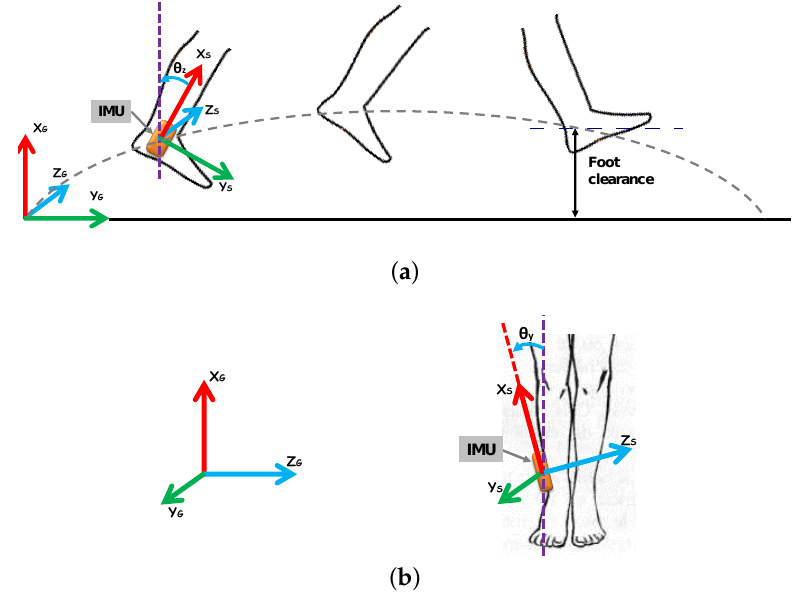
Figure 1. IMU placement and frame transformation in ( a ) the sagittal view and ( b ) the frontal view.